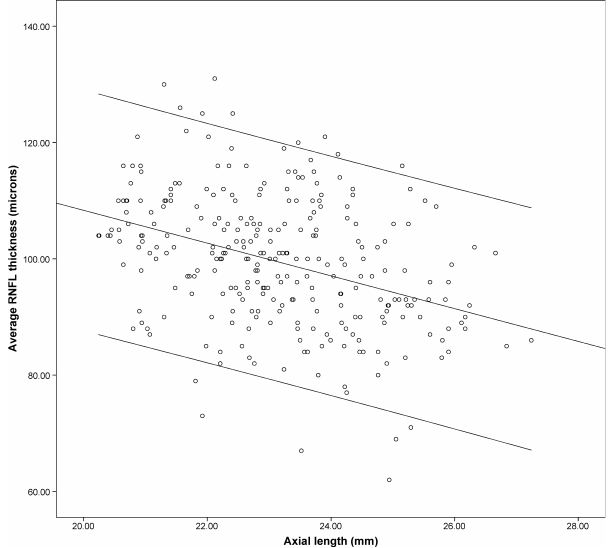
Fig. 1. Correlation between average RNFL thickness (m (cid:1) ) and AL (mm).